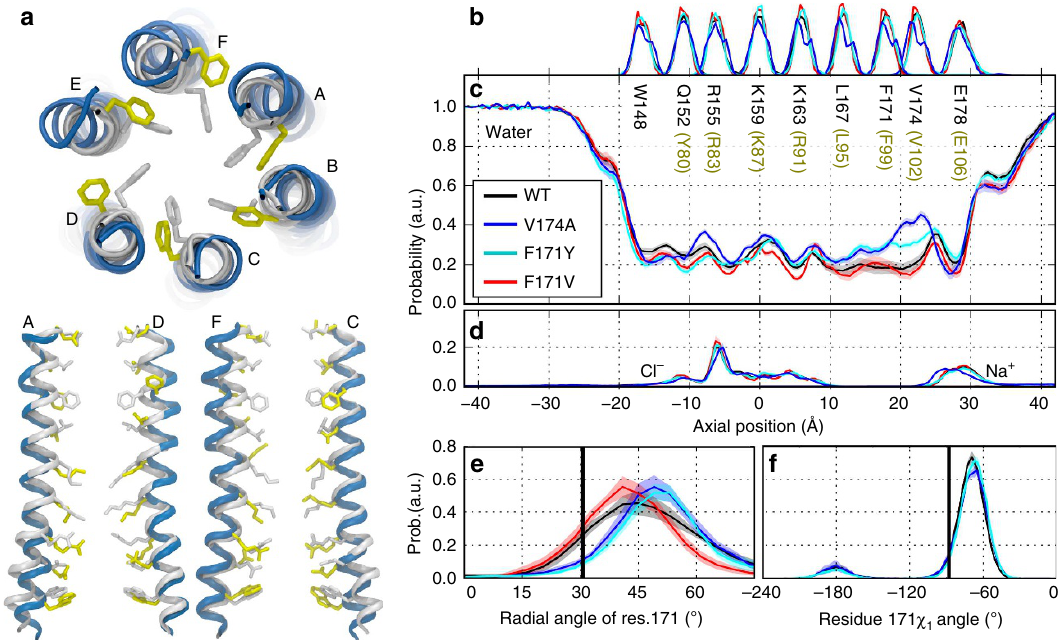
Figure 5 | Structural fluctuations and hydration of the dOrai channel pore from MD simulations. ( a ) Superposition of the dOrai crystal structure (white) and a snapshot from MD simulations of WTdOrai highlighting lateral displacement of F171 side-chains (pore helices in blue, F171 in yellow) as viewed from the top. The lower cartoons depict two pairs of diagonal subunits (labelled A, D and F, C) from this snapshot viewed from the side orientation. ( b ) Average distributions of the axial position of C a atoms for all pore-lining residues. The residues corresponding to human Orai1 are shown in brown. Data in b – f were computed from simulations of WT (black) and of V174A (blue), F171V (red), and F171Y (aqua) mutant channels. Average distribution of ( c ) water oxygen atoms and ( d ) Na þ and Cl (cid:2) ions along the pore axis. The water occupancies of V174A and F171Y mutants deviate from those of WTand F171V dOrai most significantly in the hydrophobic stretch of the pore. ( e ) Average distribution of the radial angle of residue 171 defined as the angle between the pore axis, the centre of mass of the two helical turns centred at residue 171, and the C a atom of residue 171. The mean and standard error of mean of these distributions over all simulation repeats in degrees is 46 ± 2 for WT; 43 ± 2 for F171V; 50 ± 2 for V174A; 50 ± 1 for F171Y. The radial angle in the crystallographic structure (31 (cid:2) ) is shown as a black vertical bar for reference. ( f ) Average distribution of side-chain torsion w 1 of residue 171 in WT, V174A and F171Ymutants. The w 1 of residue 171 in the crystallographic structure ( (cid:2) 88 (cid:2) ) is shown as a black vertical bar for reference. F171V is not included in this analysis as motion involving rotation of the valine side chain w 1 angle cannot displace the side chain away from the pore. ( b – e ) The traces depict values ±